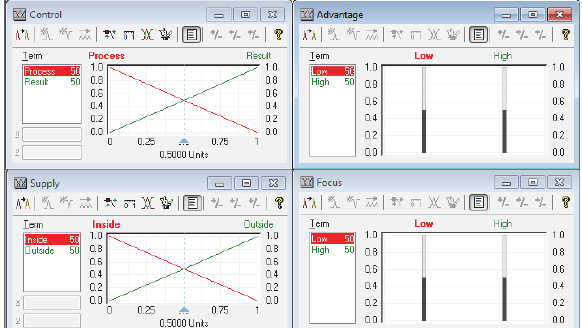
Fig. 7. Studying the results of strategies alignment in the average controlling of process and average supplying from the inside